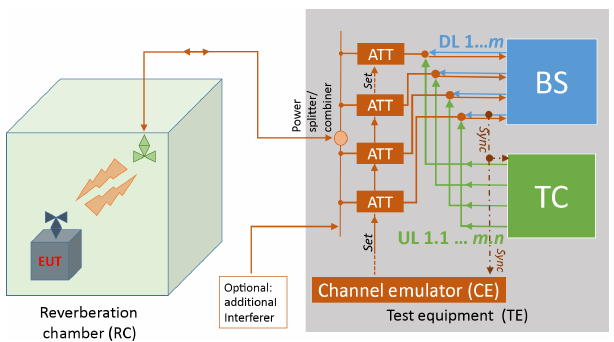
Figure 13. Test setup for EUT with integrated